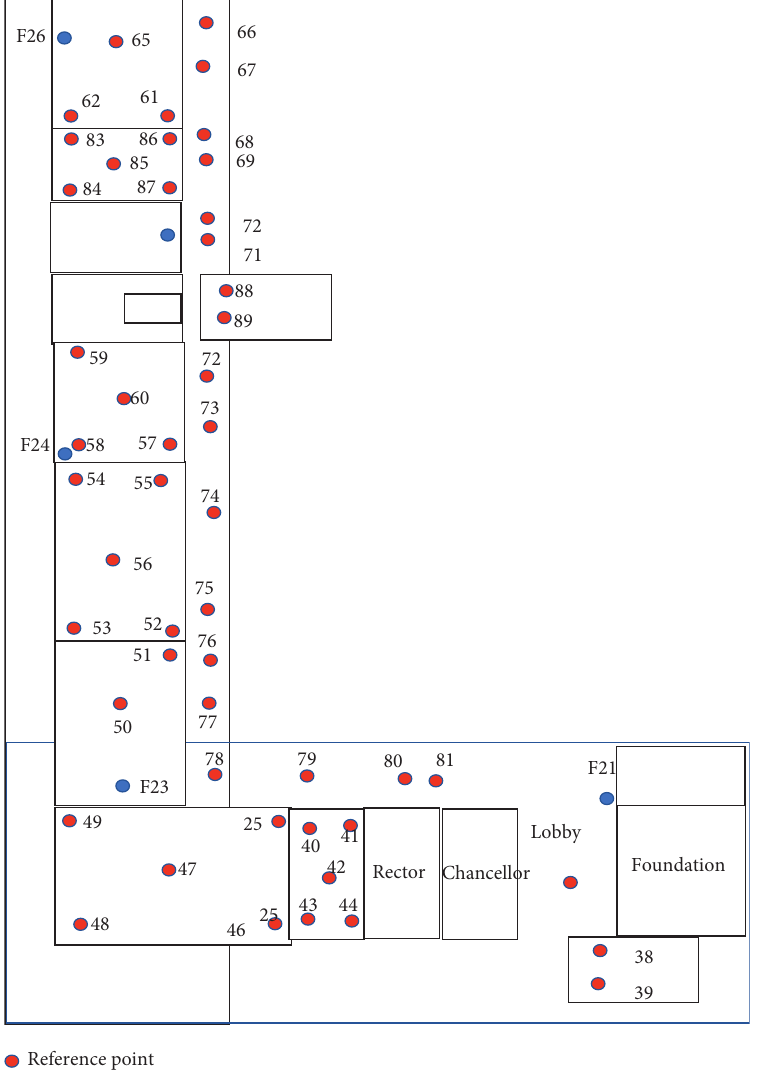
Figure 2: The AP position and reference point design on floor